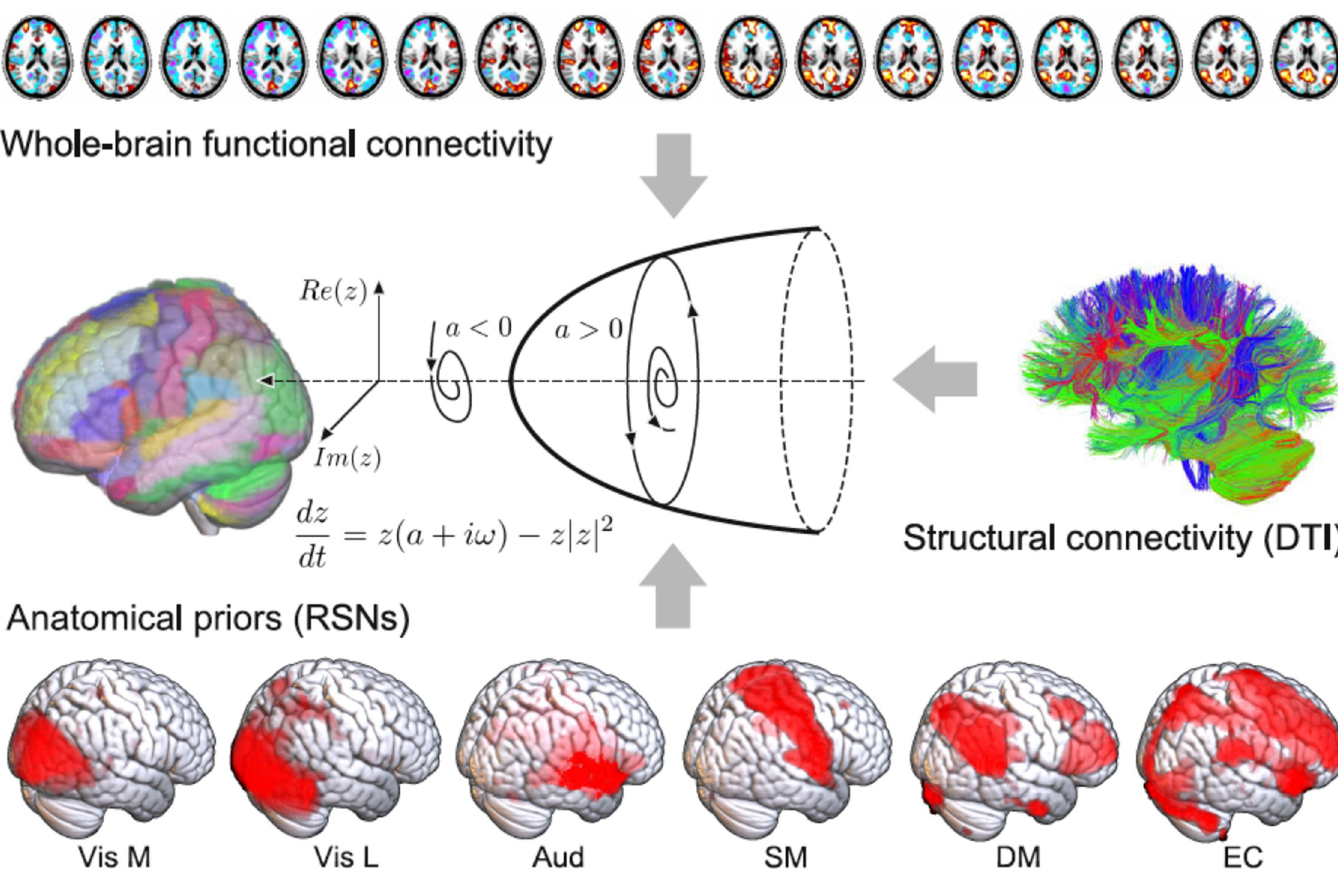
Fig 1. Procedure followed to construct the whole-brain computational model. The dynamics of each node in the structural connectivity matrix are represented by a Hopf bifurcation with three possible dynamical regimes depending on the value of the bifurcation parameter: stable fixed-point ( a < 0), stable limit cycle ( a > 0) and a bifurcation between both regimes ( a � 0). The local bifurcation parameters are optimized to reproduce the empirical FC matrix computed from fMRI data acquired during different states of consciousness, and constrained in their variation by the six RSNs (anatomical priors) reported in Beckmann et al. (2006): Vis M (medial visual), Vis L (lateral visual), Aud (auditory), SM (sensorimotor), DM (default mode), EC (executive control). https://doi.org/10.1371/journal.pcbi.1009139.g001 PLOS Computational Biology | https://doi.org/10.1371/journal.pcbi.1009139 July 27,